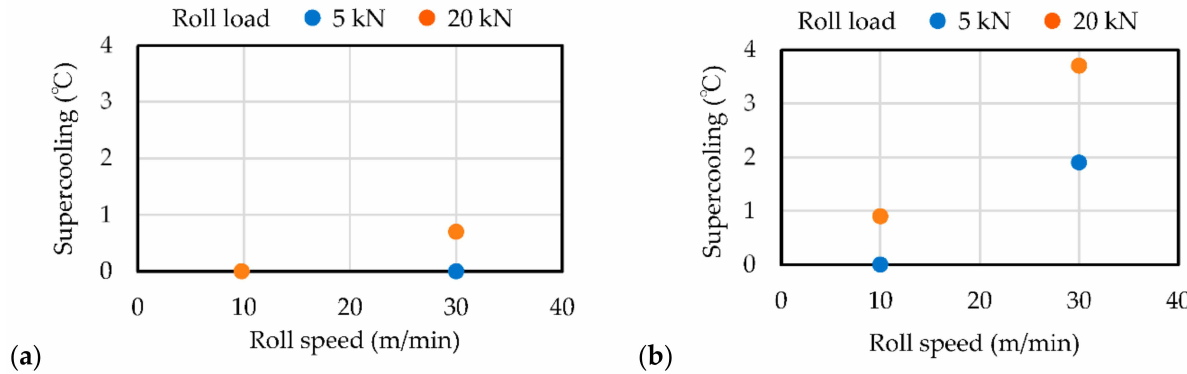
Figure 6. Effects of roll materials on supercooling of liquidus temperature of strip. The rolling speed was 10 or 30 m/min, and the roll load was 5 or 20 kN. ( a ) Mild steel roll and ( b ) copper roll.